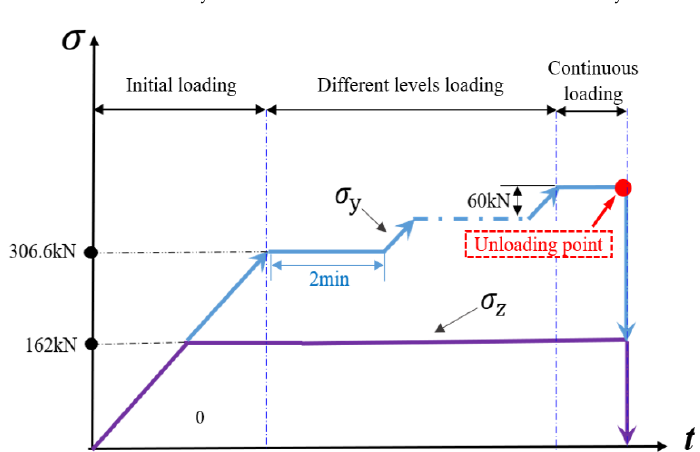
Figure 4. Schematic diagram of the loading path.